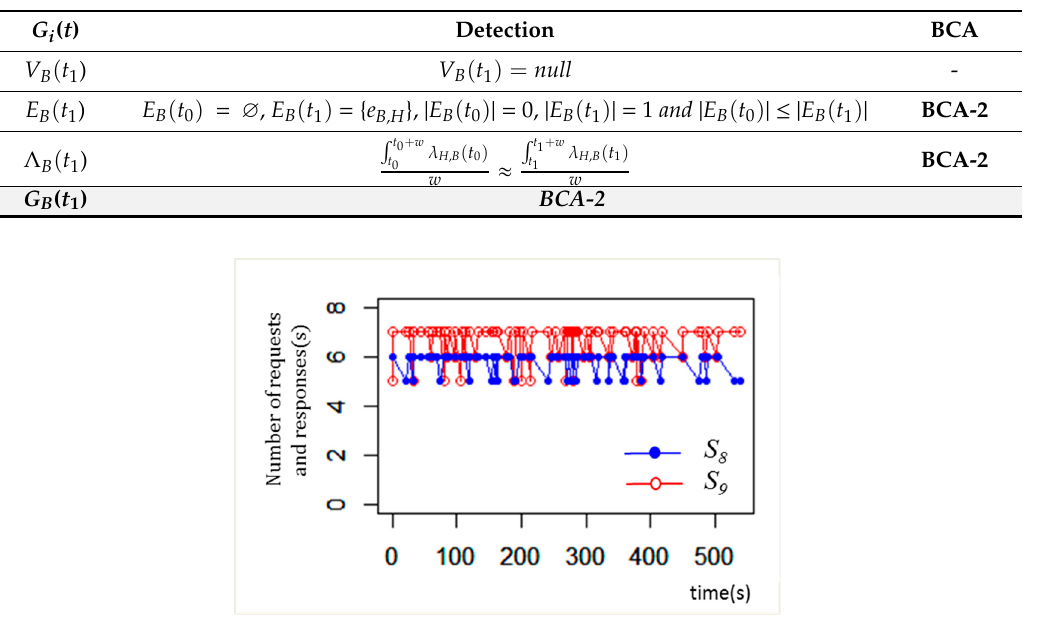
Figure 13. Iterative behavior of host B. Table 10. BCA-2 detection on host B at t 1 during a password attack.